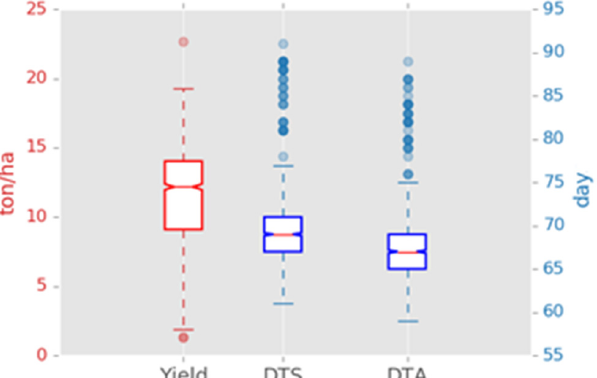
Figure 2. Box plots of the ground truth field data.